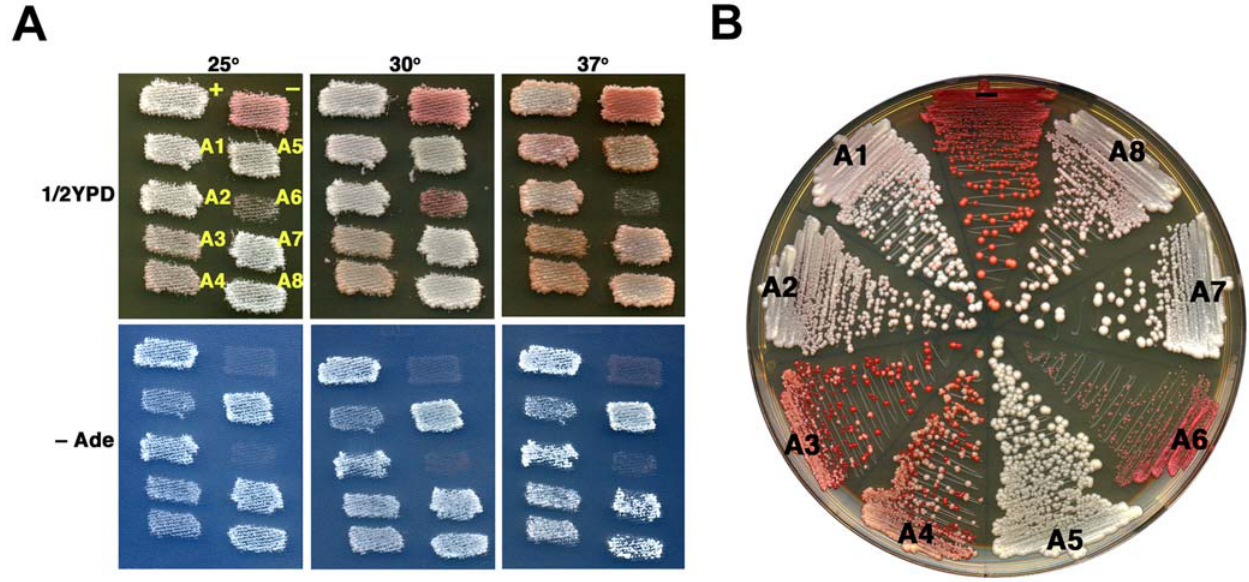
Figure 9. [ URE3 ] prion phenotype of cells expressing different Ssa proteins. (A) Patches of 1161 strains A1-A8, as indicated (see Figure 5A), were grown on 1/2YPD and replica-plated onto 1/2YPD and –Ade plates as in Figure 5A. Plates were incubated at the indicated temperature for two days. Cells expressing Ssa6p are unable to propagate [ URE3 ] and are uniformly [ ure-o ]. (B) Streaks of cells from the same cultures used in (A) were incubated two days at 30 u followed by three days at 25 u . Red colonies in streaks arise from cells that lost [ URE3 ] before forming the colony. Red sectors in pink or white colonies are progeny of cells that lost [ URE3 ] during growth of the colony. [ URE3 ] ( + ) and [ ure-o ] (–) variants of wild type strain 1075 are included for comparison.